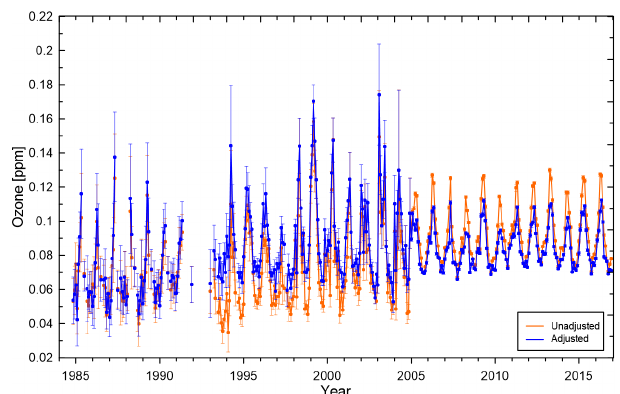
Figure 4. Monthly mean zonal mean ozone mixing ratio at 182hPa between 25 and 30 ◦ N as calculated from all data sources before (orange line) and after (blue line) the homogenization process has been applied to the source data. For more details see text.